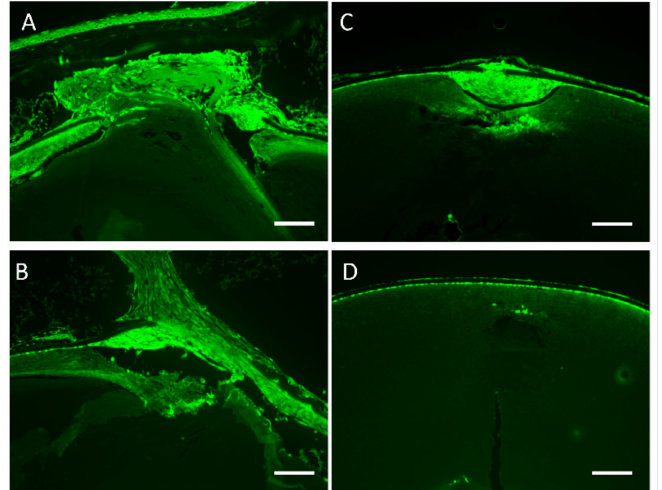
Figure 7. α -SMA was expressed in fibroblastic tissues observed in hDCN-Tg and WT animals. Paraffin sections of lenses of WT ( A , B ) and hDCN-Tg animals ( C , D ) with injury at 5 ( A , C ) and 10 ( B , D ) days were prepared and immunostained with anti- α SMA Ab. Scale bar, 100 µ m. Results are representative of six independent